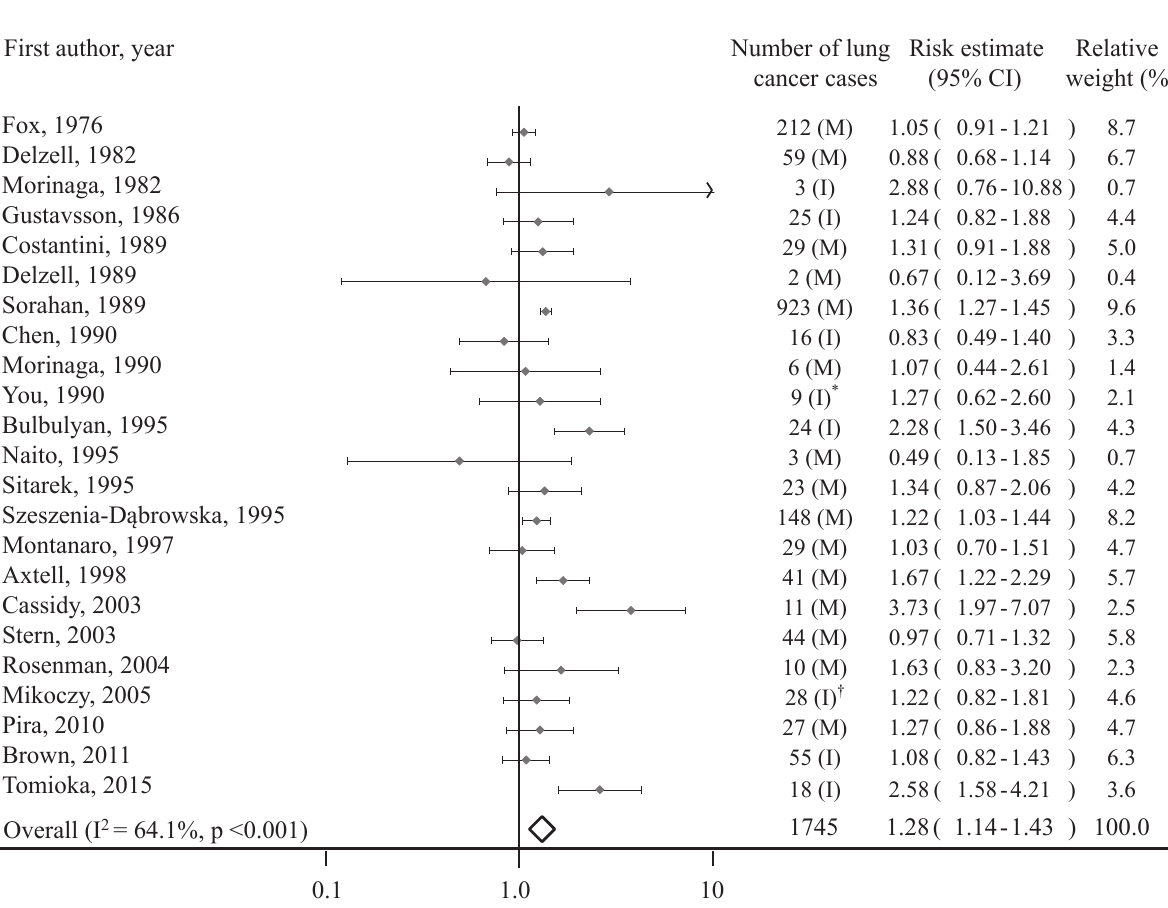
Figure 2. Forest plot of studies included in the meta-analysis of exposure to benzidine and/or beta-naphthylamine and lung cancer: all studies combined. I, incidence; M, mortality. * Respiratory cancer. † Obtained by contacting